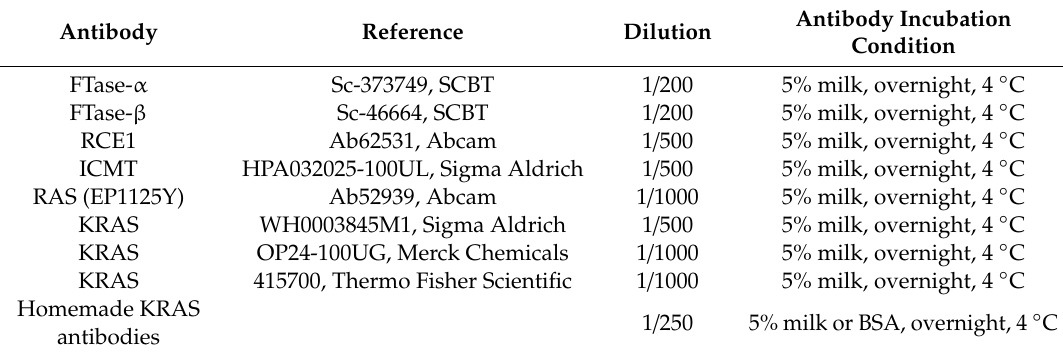
Table 3. List of antibodies used in Western blot